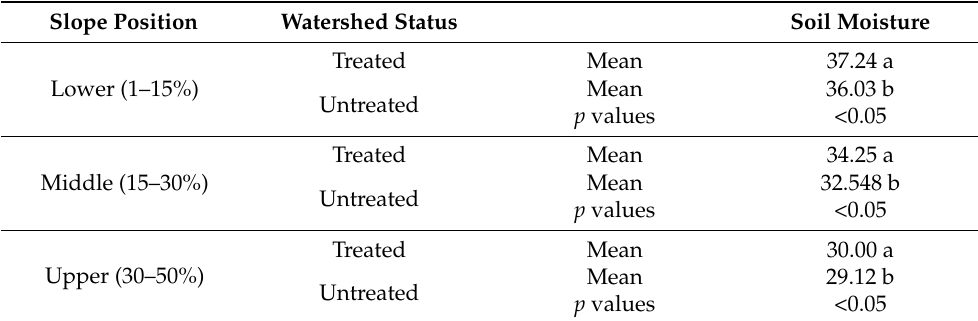
Table 4. Impacts of slope positions on soil moisture in Debre Mewi and Sholit watersheds.